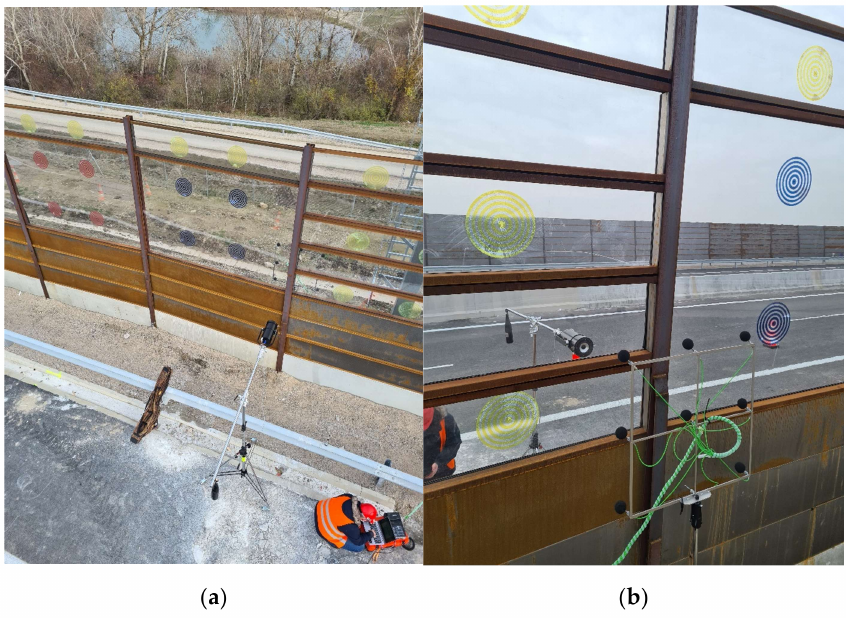
Figure 12. ( a ) Location of the sound source; ( b ) location of the microphone set in situ. D M = 0.25 m—horizontal distance (microphone grid, microphone no. 5—reference plane of the source) at a height h S